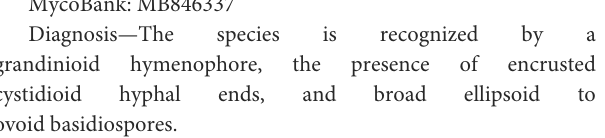
the absence of cystidia and cystidioid hyphal ends, and small ellipsoid basidiospores. In the phylogenetic tree (Figure